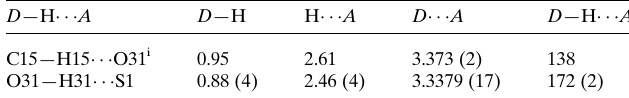
Table 4 Hydrogen-bond geometry (A˚ , (cid:5) ) for 1 .